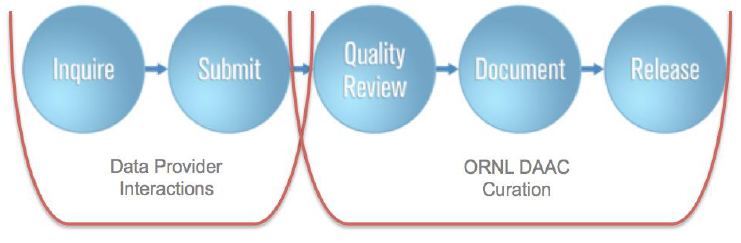
Figure 5. High-level representation of the SAuS workflow.